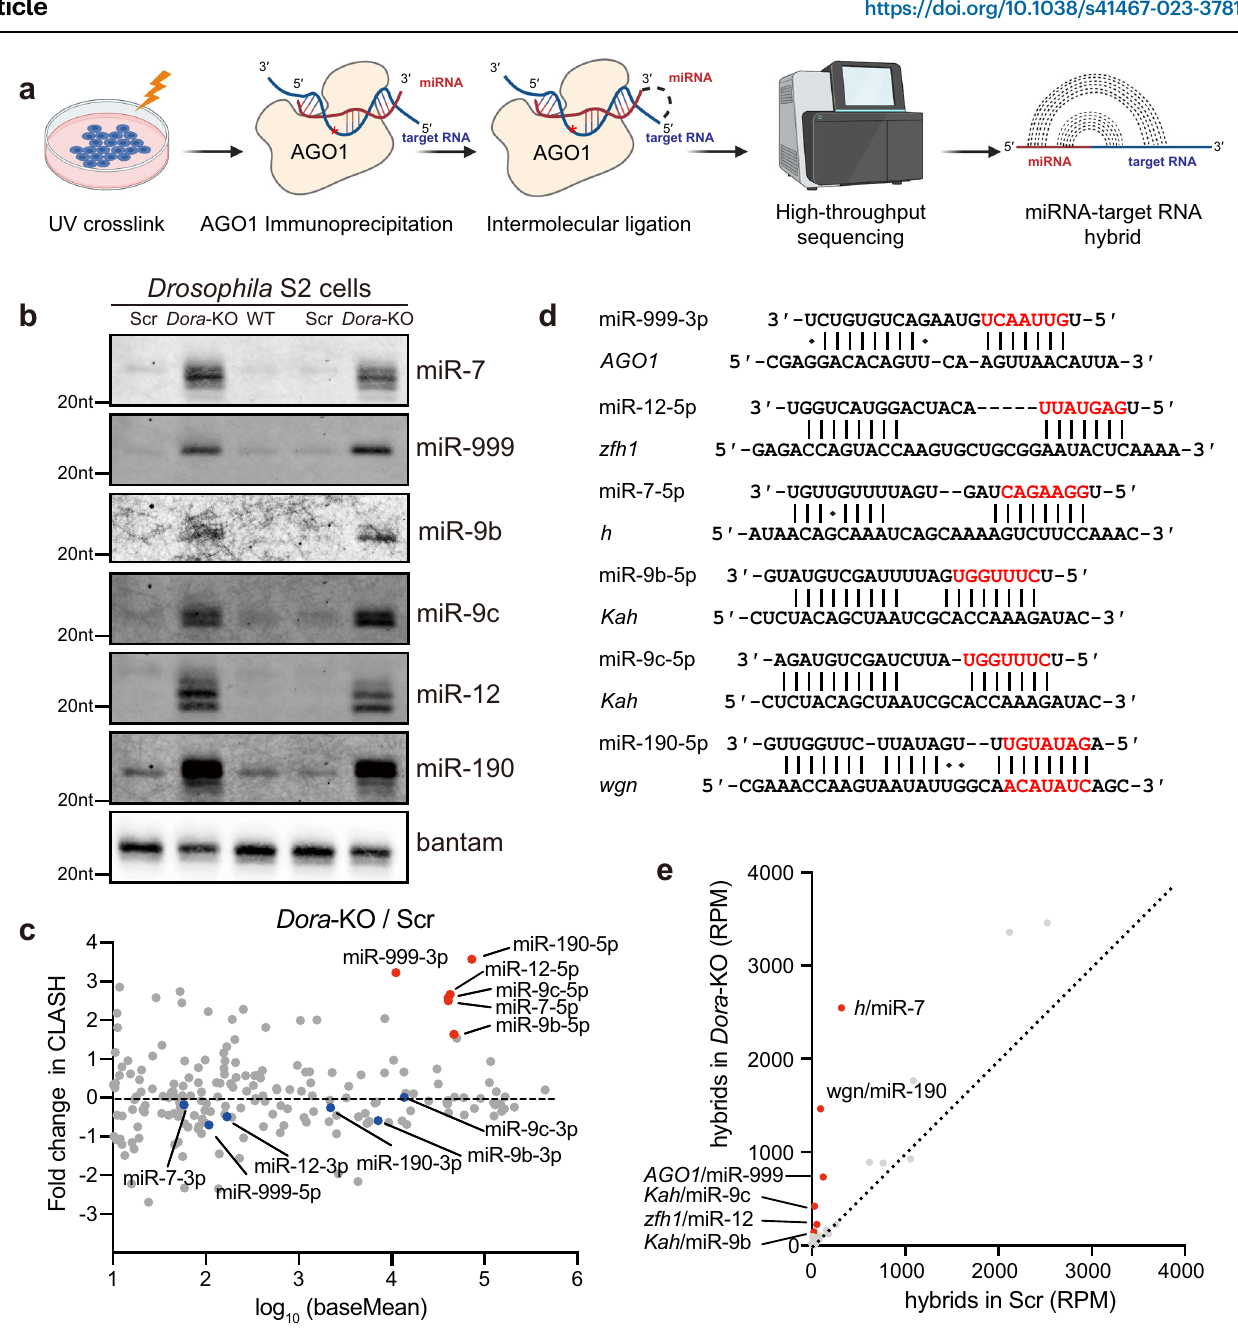
loading control. n =3 biological replicates. c Changes in miRNA abundance observed from CLASH between Dora -KO and control-KO S2 cell. Guide strands of the Dora -sensitive miRNAs are indicated by red dots, and the blue dots represent their passenger strands. d Base-pairing pattern of miRNAs and potential TDMD triggers. Red letters represent miRNA seed region. e The comparison of potential TDMDmiRNA-targetRNAhybridsinAGO1-CLASHdataobtainedfrom Dora -KOand control-KO (Scramble) S2 cells. Source data are provided as a Source Data fi